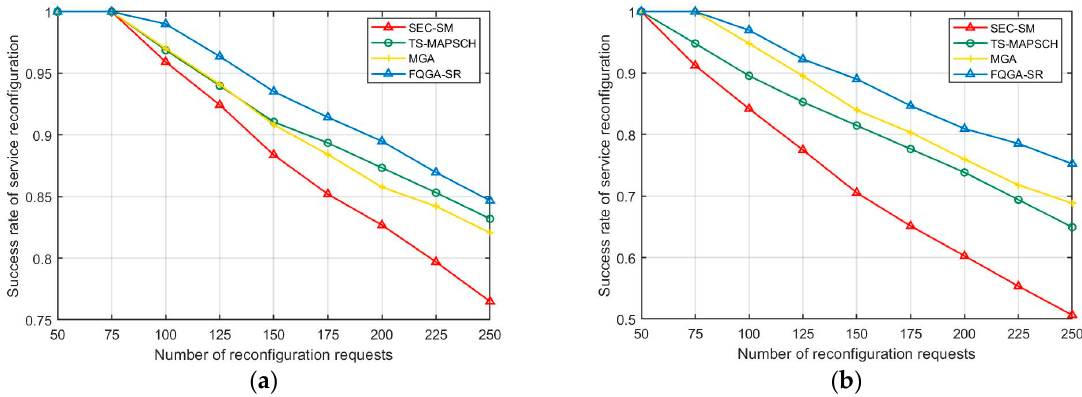
Figure 5. Comparison of the success rate of service reconfiguration: ( a ) arrival rate of service reconfiguration requests λ = 0.05; ( b ) arrival rate of service reconfiguration requests λ = 0.2.